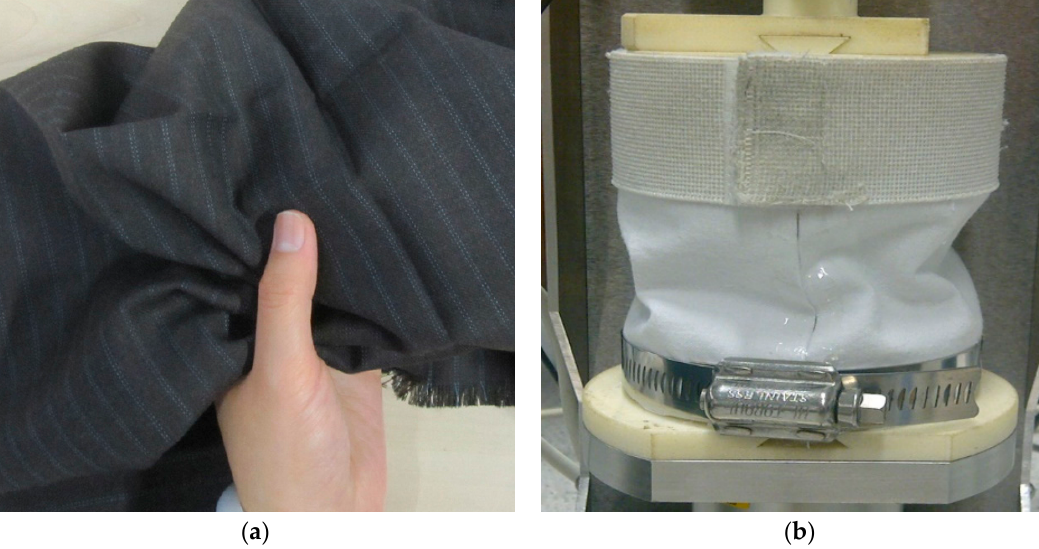
Figure 2. Compressive fabric deformations, ( a ) by human hand and ( b ) by Leeds University Fabric Handle Evaluation System (LUFHES) objective handle method. Ref: http://www.innovationintextiles.com/objectively-evaluating-fabric-handle/.